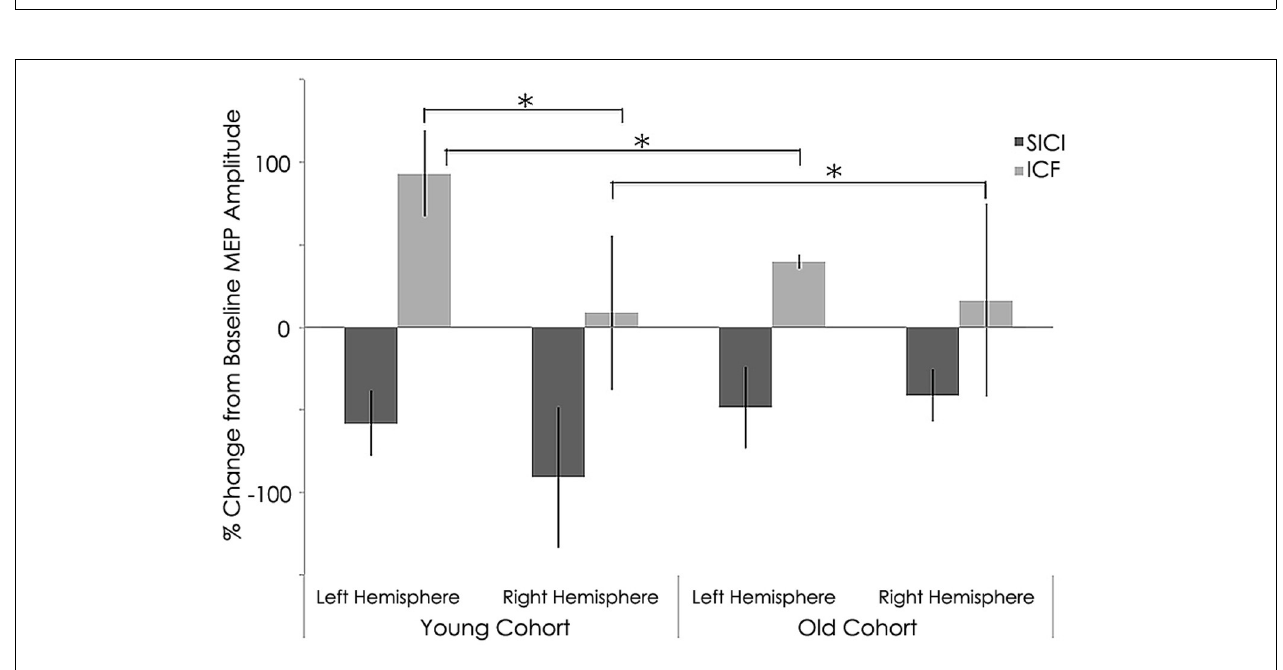
FIGURE 4 | Interhemispheric characteristics of the study sample prior to rTMS. Non-significant statistical differences in Motor evoked potentials (MEPs) between right and left hemispheres among young subjects